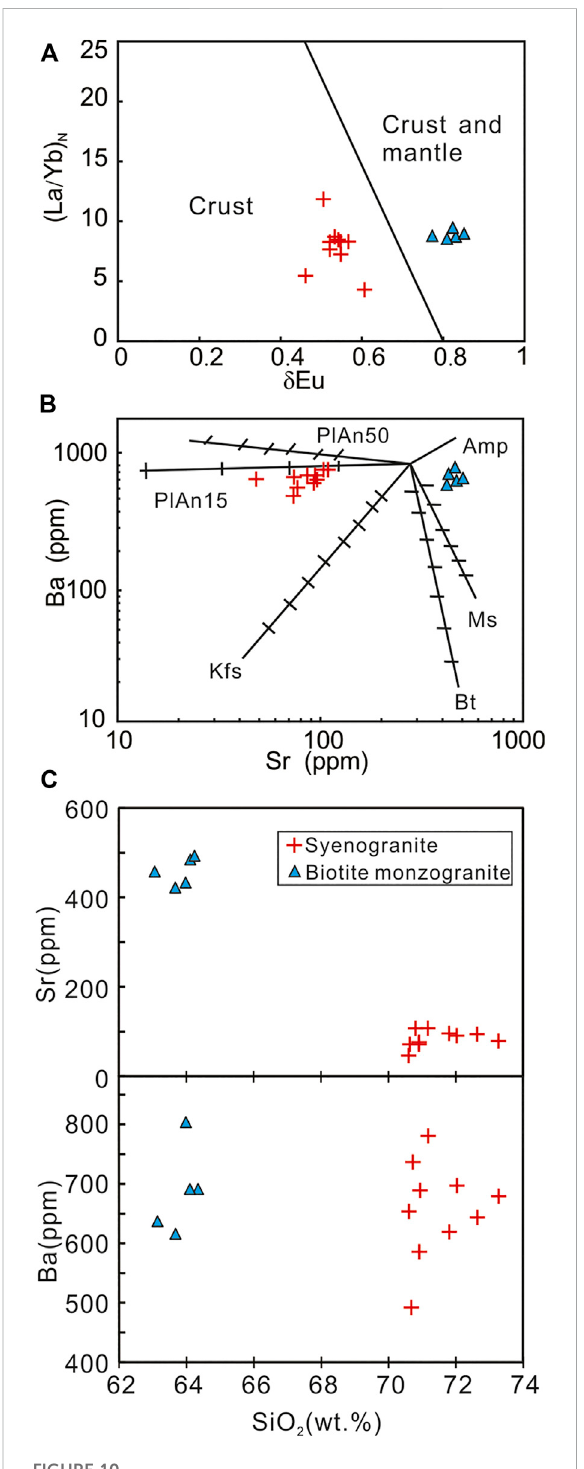
(Figure 7A), no signi fi cantly negative Eu anomalies (Figure 7B) and a weak fractional crystallization trend of plagioclase (Figure 10B). However, they have high Ba content, and in the diagram (Figure 10C), SiO 2 is not correlated negatively